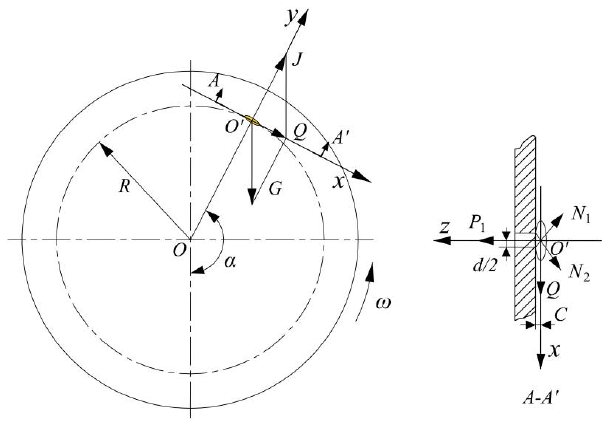
Figure 3. Stress analysis of rice seeds in the seed-carrying area: R is the radius of the circle where the suction hole is located mm; Q is the guaranteed minimum resultant force of the coated rice seeds that are adsorbed by the suction holes N; P 1 is the suction force at the air outlet of the suction hole N; d is the suction hole’s diameter in mm; and C is the distance between the centroids of the rice seed and the plane of the suction hole in mm; G is the rice seed’s gravity N; J is the centrifugal inertial force that is generated by the rotation of the rice seeds with the plate N; α is the angle between the G and J forces; O is the center of the seed plate; O' is the centroids of the rice seed; A-A’ is the section view; x , y and z are the coordinate axes; ω is the rotation speed of the seeding plate rad/s. Rice seeds can be stably adsorbed by the suction holes and will not be detached with the synchronous rotation of the sucking plate; therefore, the following force balance con- ditions should be satisfied: